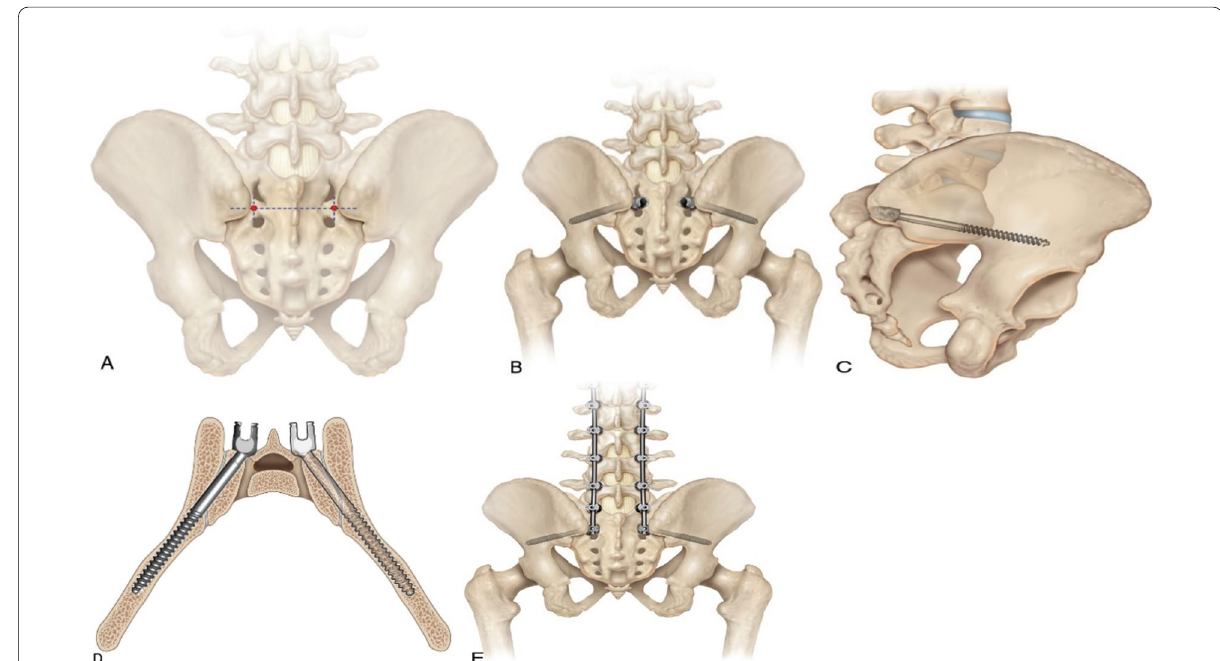
Fig. 16 Open S2AI screw insertion technique. A The entry point. B – D Coronal, sagittal, and axial views, respectively, of the final trajectory. E The connection of the S2AI screws to the longitudinal rods completes the construct [3]